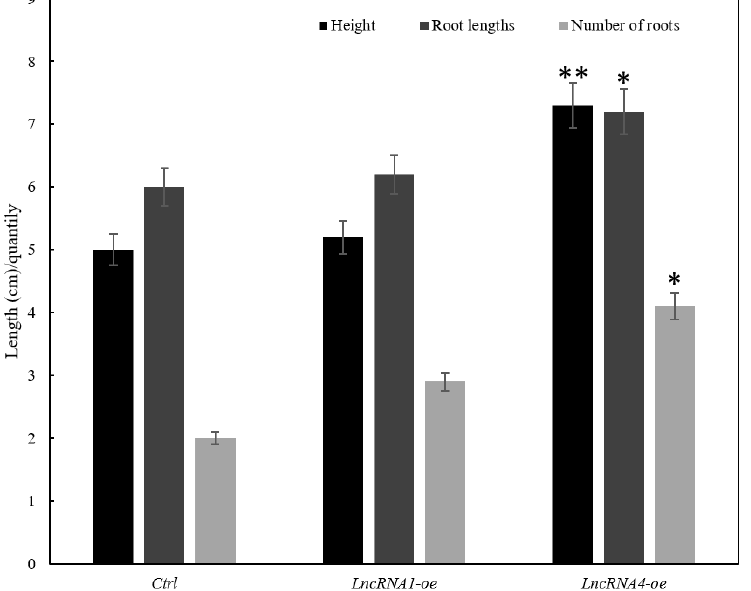
Figure 7. Plant height and root of overexpression and wild type 84K poplar trees. Bars represented standard errors (SE), * represented the significant difference ( p < 0.05), and ** represented the highly significant difference ( p < 0.01). Values were reported as means ± SE ( n = 4).